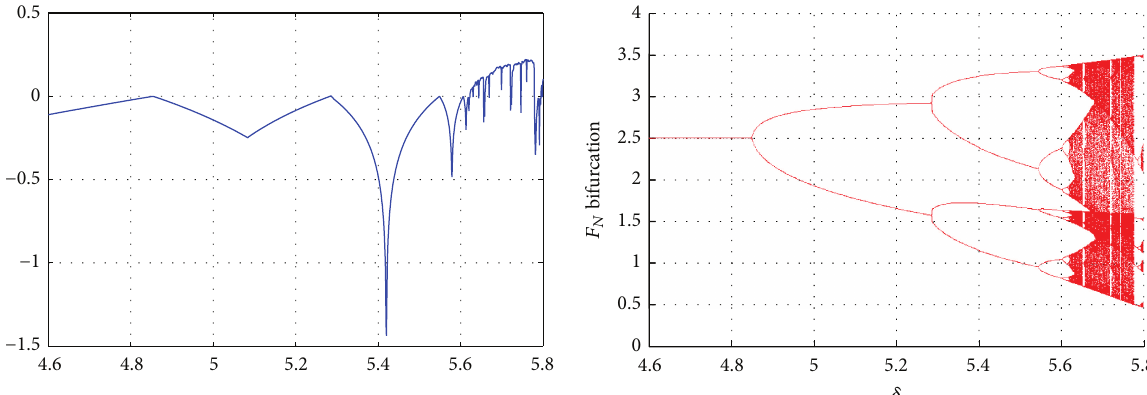
Figure 4: Largest Lyapunov exponents and bifurcation diagram of system (25) for 𝑎 = 0.8 , 𝑏 = 0.8 , 𝑐 = 0.4 , 𝑑 = 0.2 , 𝑘 = 5 , 𝑙 = 2 , and = 0.03 with the initial value of (𝑥,𝑦) = (1,1) and 𝛿 covering [4.6, 5.8] 𝐴 1